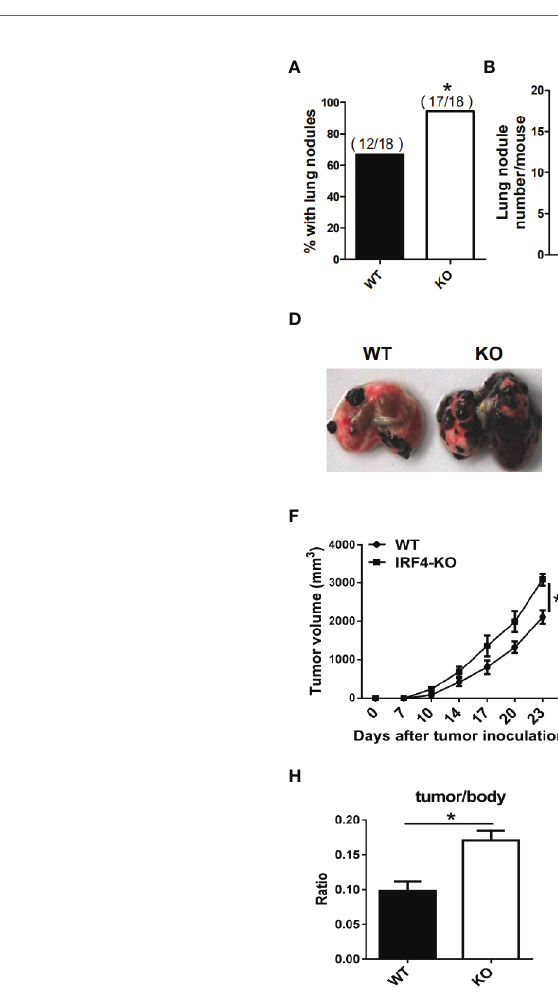
FIGURE 2 | Interferon regulatory factor 4 (IRF4) de fi ciency in the host facilitates tumor development. (A – E) WT (n=18) or IRF4 KO (n=18) mice were injected with B16-F10 cells via the tail vein; mice were sacri fi ced after 3 weeks. (A) Percentage of mice with lung nodules; * P < 0.05, c 2 test. (B) The number of lung nodules per mouse; * P < 0.05, Student ’ s t test. (C) Lung nodule area per mouse using NIH ImageJ; ***p < 0.001, Mann-Whitney test. (D) Representative images of lungs. (E) Representative images of lung H&E staining; arrows indicate metastases. (F – I) Tumor growth model; mice were subcutaneously injected with 1×10 5 B16-F10 tumor cells (n=6). Primary tumor growth was monitored (F) ; * P < 0.05, Mann-Whitney test. Representative images of tumor (G) . The ratio of tumor (H) or spleen (I) weight to mouse body weight; * P < 0.05, Student ’ s t